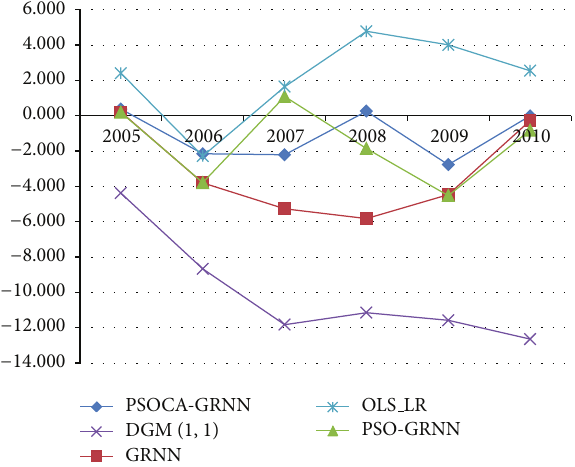
Figure 7: Relative error of forecasting results of PSOCA-GRNN, GRNN, PSO-GRNN, DGM (1, 1), and OLS LR models.